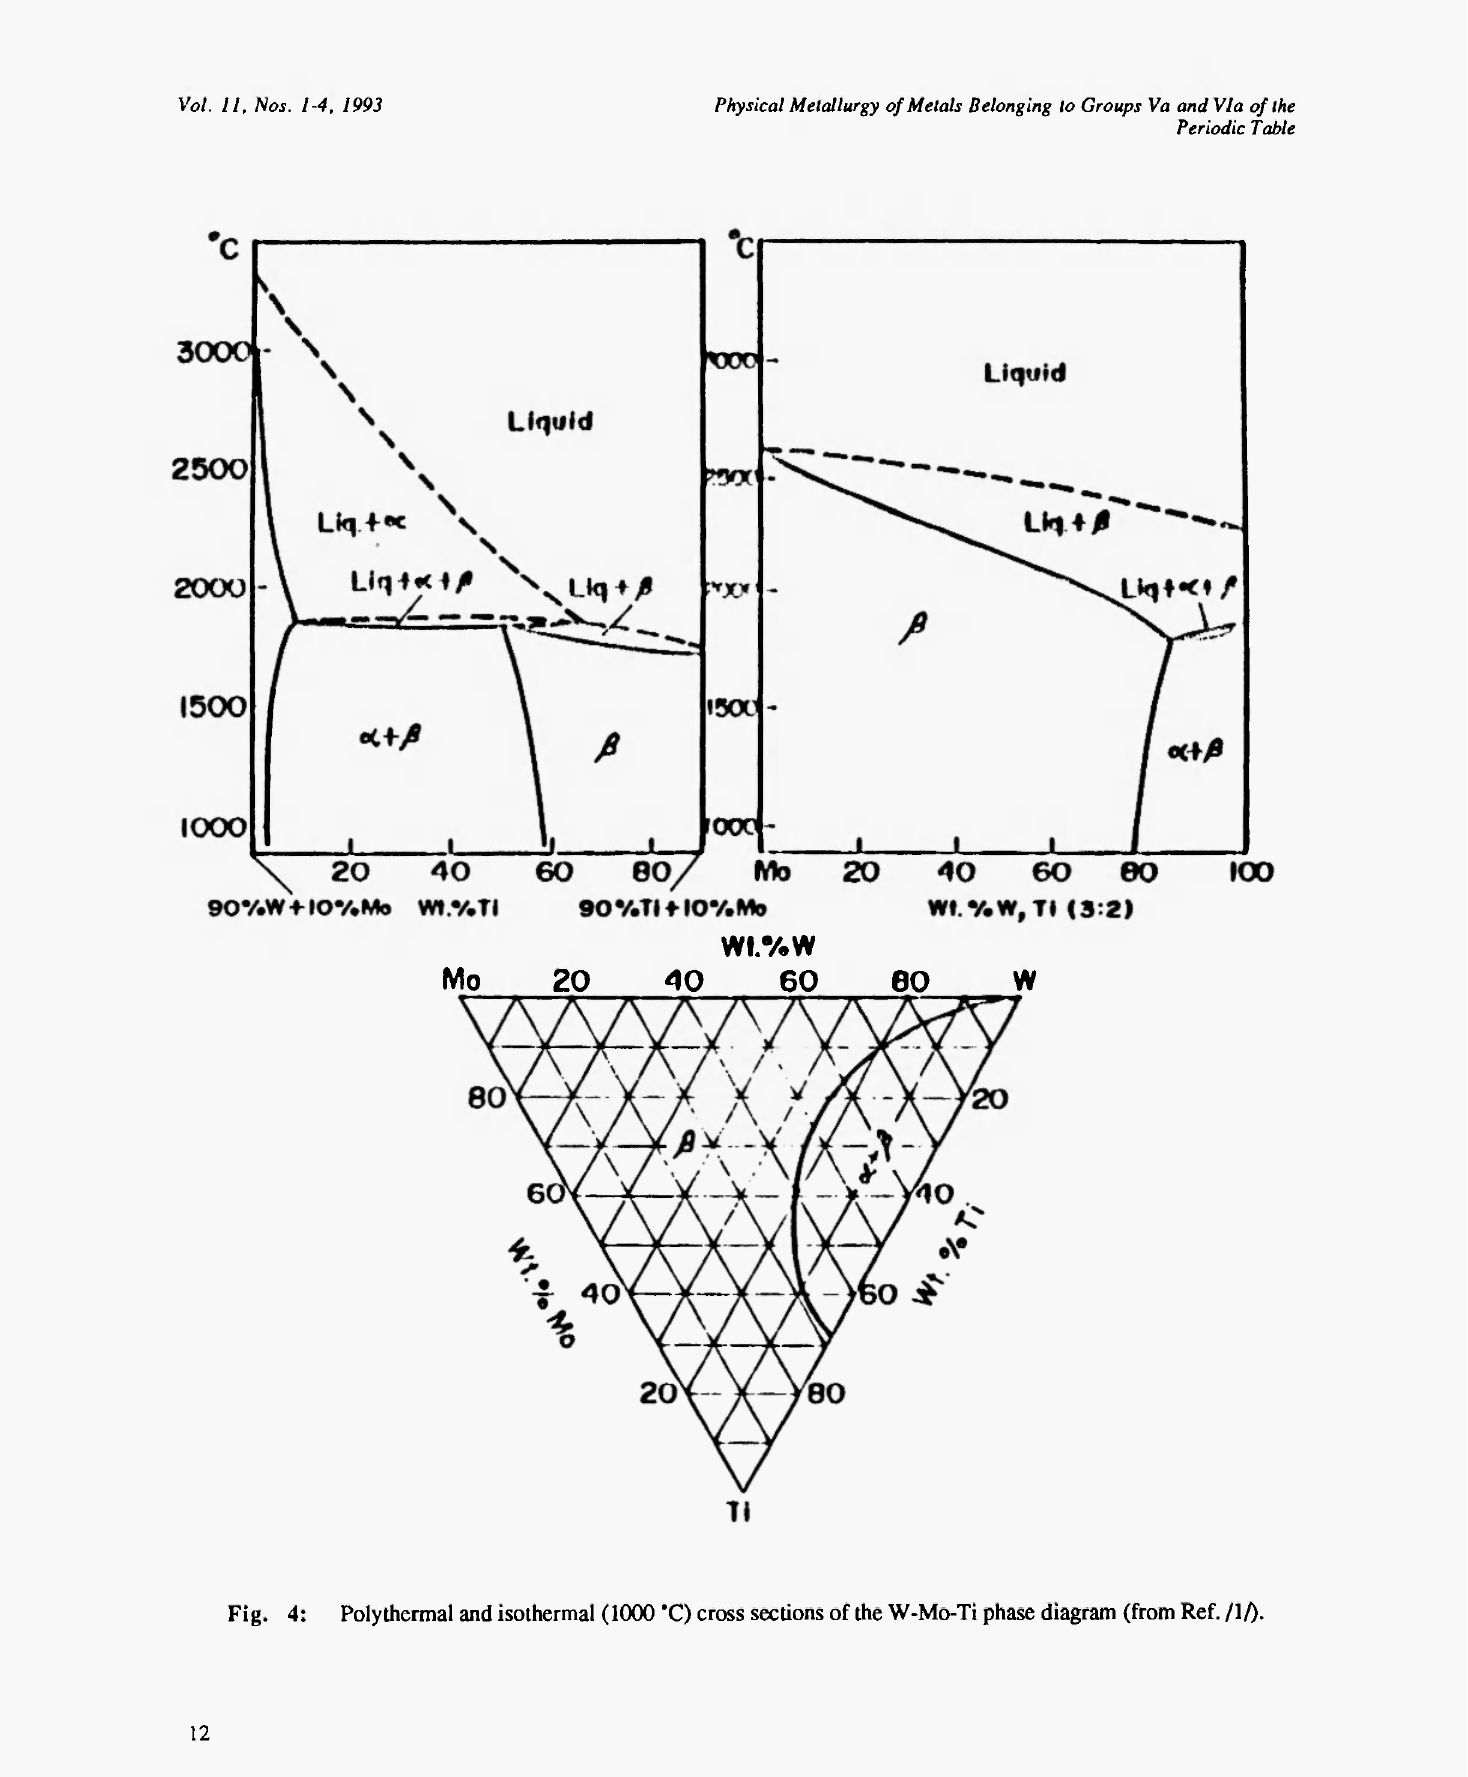
Fig. 4: Polythermal and isothermal (1000 'C) cross sections of the W-Mo-Ti phase diagram (from Ref.